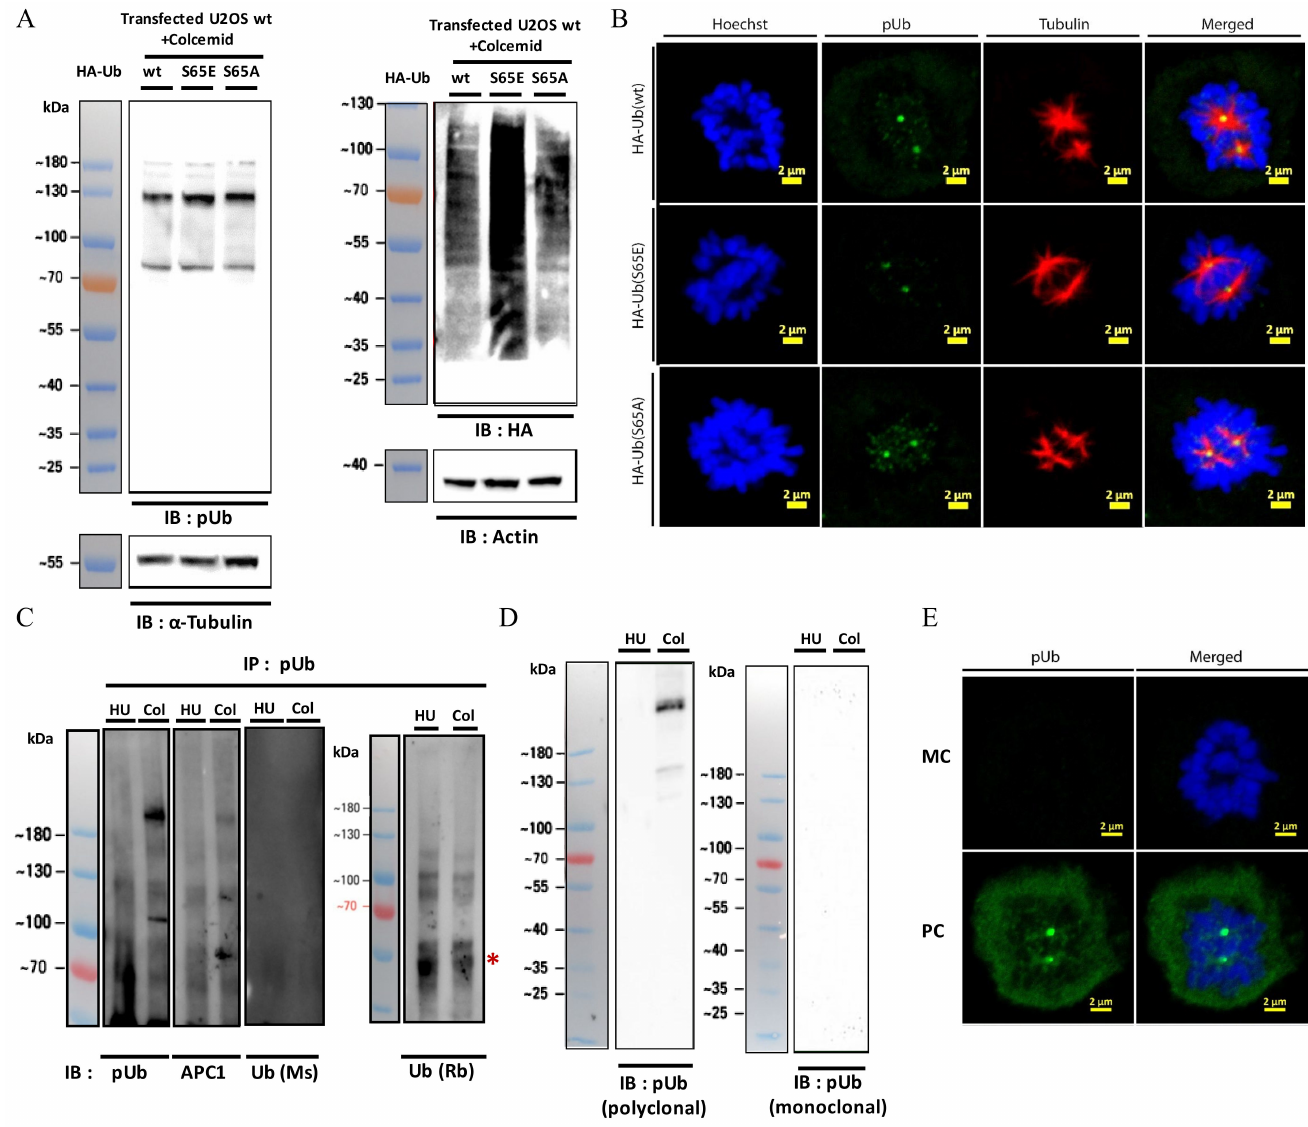
Figure 5. Overexpression of Ub S65 mutants does not affect pUb signal in mitosis. ( A ) Western blot analysis of mitotic cells transfected with HA tagged Ub mutants using pUb and HA antibodies; ( B ) confocal images of mitotic cells transfected with the relevant Ub mutants stained with pUb and α -Tubulin antibodies. Scale bars are 2 micron; ( C ) mitotic lysates of U2OS cells were subjected to immunoprecipitation with pUb antibody and the immunoprecipitates were probed with pUb, APC1 and Ub antibodies; ( D ) Western blot analysis of mitotic cell lysates using monoclonal (MC) and polyclonal (PC) pUb antibodies; ( E ) confocal images of mitotic cells stained with MC and PC pUb antibodies. Western blot signals are HRP chemiluminescence and are shown as false fluorescence. Scale bars are 2 micron. * antibody heavy